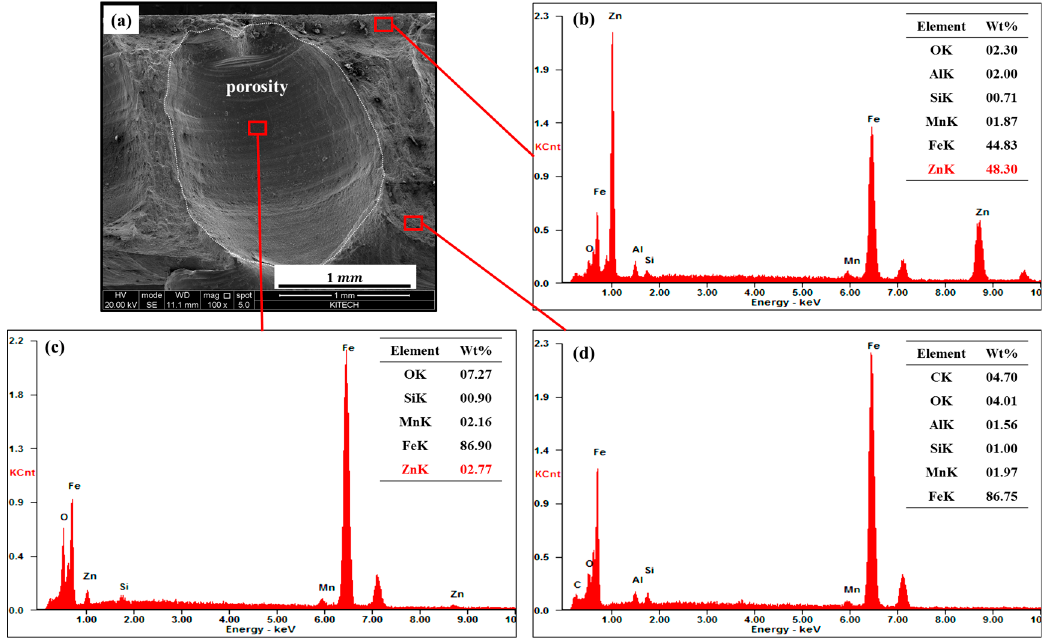
Figure 8. Analysis of EDS components at porosity welded and non-welded locations: ( a ) 100× image of the welded section; EDS component analyses of the ( b ) zinc coating, ( c ) porous location in the weld, and ( d ) locations where no pores are generated.